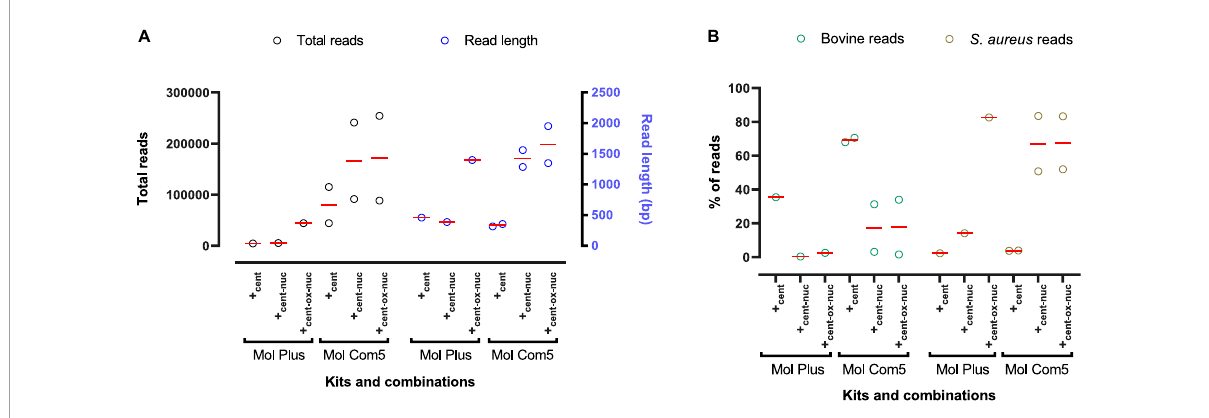
FIGURE3 An overview of MinION sequencing results following DNA extraction from mastitis milk using MolYsis kits and combinations. (A) Total reads (black) and read length (blue) following using different commercial kits/combinations. (B) Percentage of reads aligned with the bovine genome (green) and S. aureus genome (olive). Each circle represents a sample, and the mean value is depicted with a red